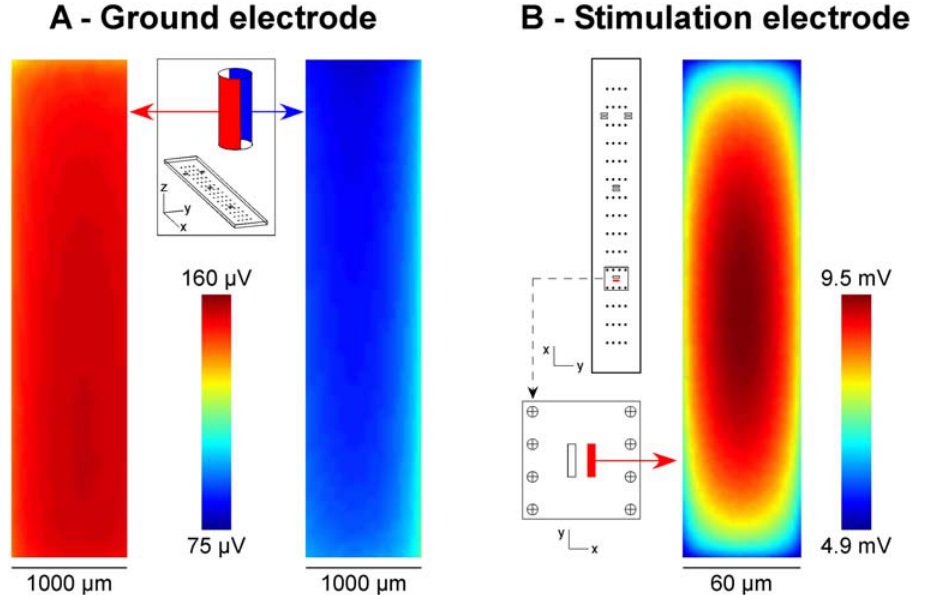
Figure 5. The spatial distribution of the potential in the medium is not uniform over the surfaces of the ground (A) and stimulation (B) electrodes. Over the ground electrode ( A , yz view), V is two times higher on the side oriented towards the stimulation electrode (left) than on the opposite side (right). Over the stimulation electrode ( B , xy view), V is two times higher at the center of the electrode than on the electrode